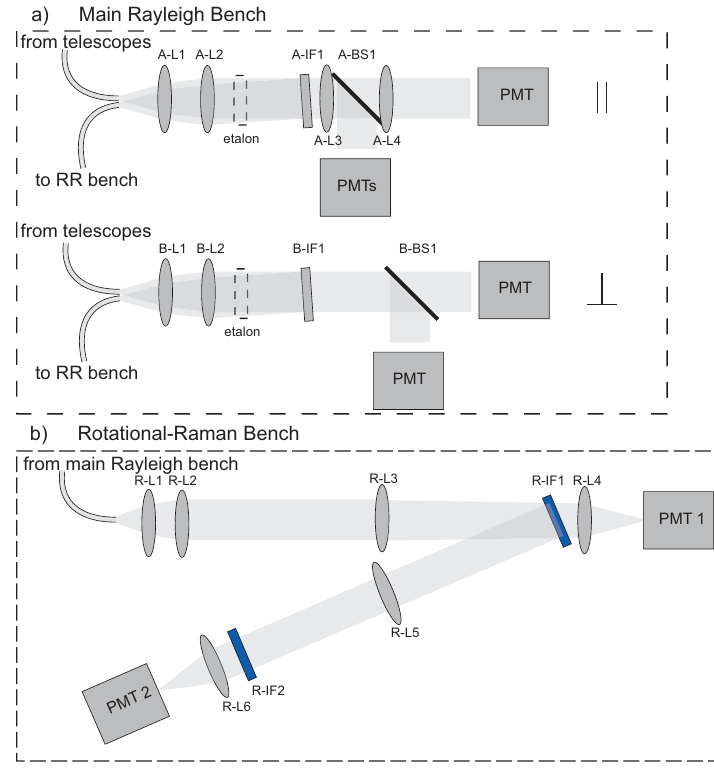
Fig. 1. Schematic setup of the pick-up and the rotational-Raman (RR) bench. (a) The pick-up of the rotational-Raman signal in the main Rayleigh bench is based on the reflected light from the interference filters (A-IF1, B-IF1). This is shown for both parallel ( a , upper branch) and perpendicular ( a , lower branch) channels. (b) Setup of the rotational Raman bench. IF: interference filter (blue: rotational-Raman filter), L: lenses, BS: beam splitter. The parameter for the interference filters of the rotational-Raman channel are given in Table 2.